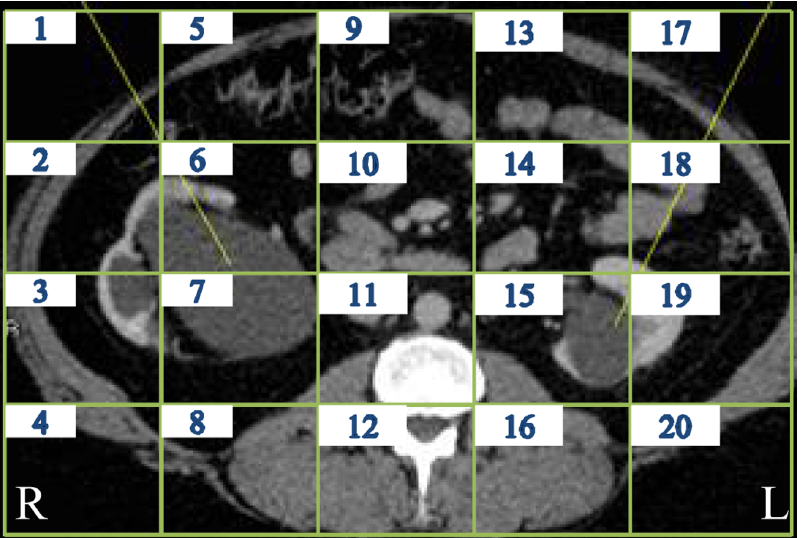
Figure 4. Cross-sectional abdominal CT-image depicting hydronephrosis. The hydronephrosis is present at the right side in area 2, 3, 6, and 7 and on the left side in area 15.